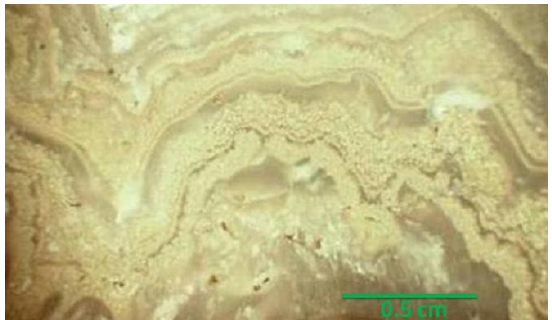
Figure 2. Photograph of multiple electrum-rich bands (>10) and opaline silica from the Sleeper “main” vein, Sleeper deposit, Nevada formed from the aggregation of electrum and silica nanoparticles. (Center of vein is toward the top of the photograph). Note: All that “glitters” is electrum in this image. In detail, the electrum-rich bands are made of “forests” of individual 3-dimensional, “self-organized” fractal dendrites (see Figure 3). Additional details about these textures are described elsewhere